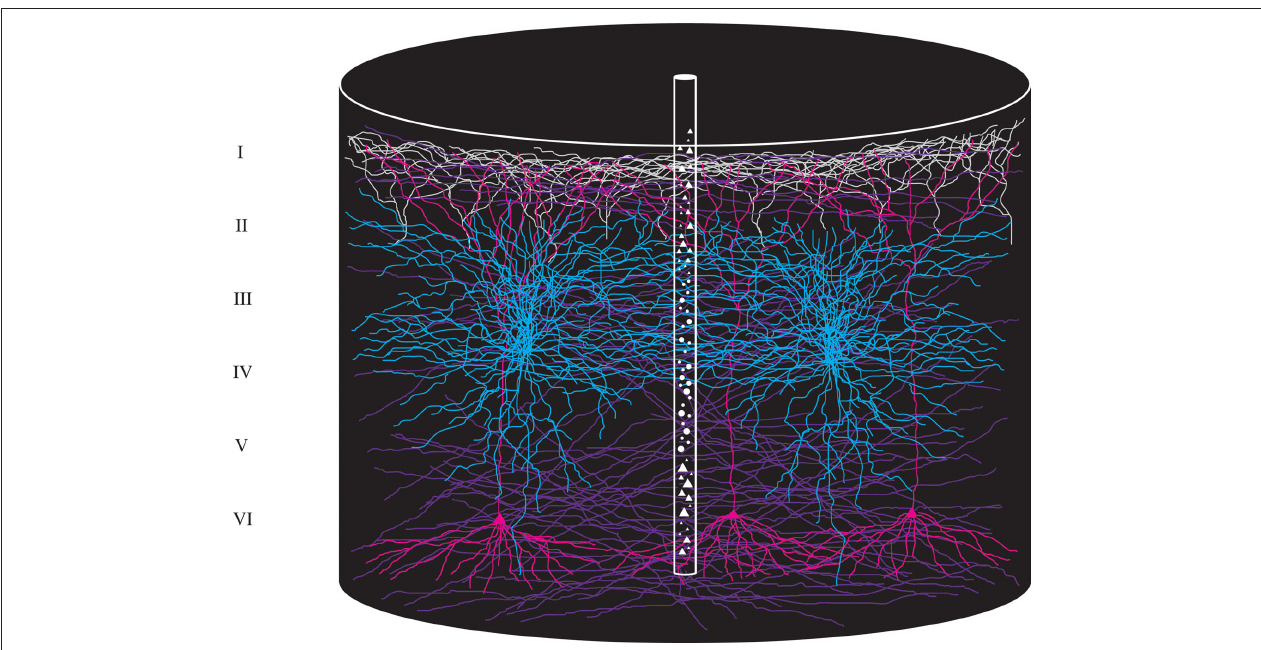
Figure 1 | Cartoon of a cylindrical volume of the visual cortex illustrating the extensive spread and overlap of dendrites and axons. Diameter of large cylinder 600 μm, diameter of small cylinder 50 μm. The small cylinder will contain dendrites from approximately 75000 neurons.